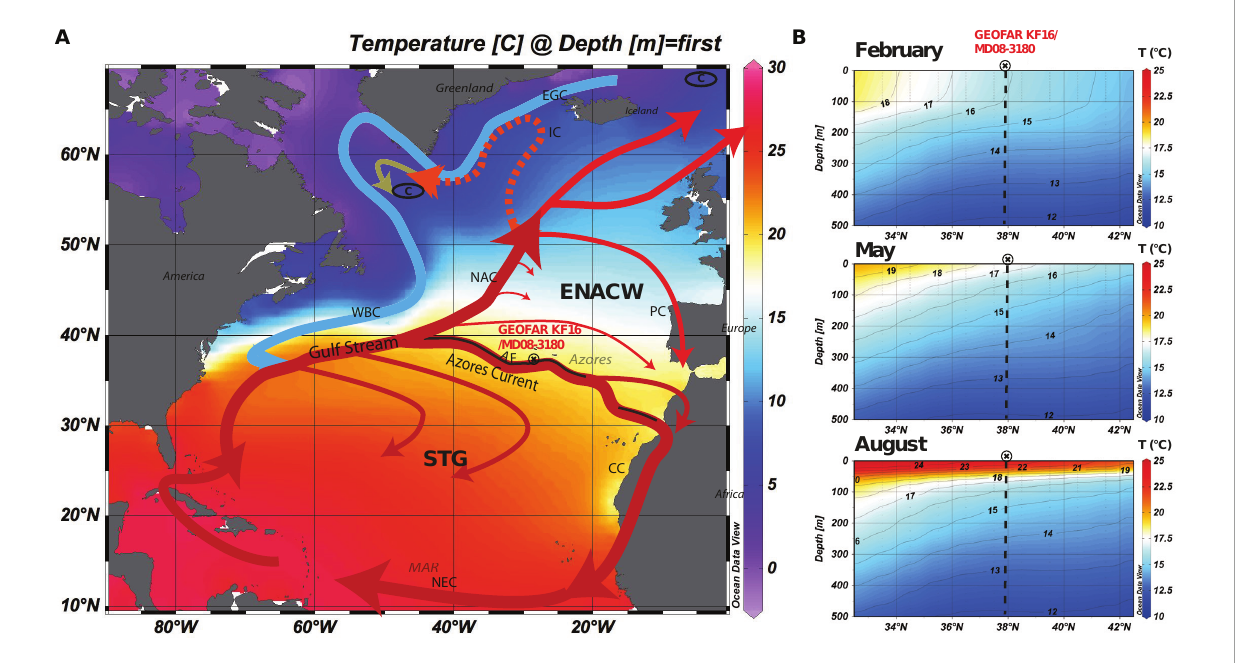
FIGURE1 (A) Main surface (solid lines) and subsurface (hatched line) currents in the North Atlantic. Warm currents are displayed in red, cold currents in blue. Color shading refers to annual mean SST (Locarnini et al., 2013). AF Azores Front, CC Canary Current, EGC East Greenland Current, ENACW Eastern North Atlantic Central Water, IC Irminger Current, NAC North Atlantic Current, NEC North Equatorial Current, PC Portugal Current, STG Subtropical Gyre, WBC Western Boundary Current, C Deepwater convection sites. (B) Cross sections on the modern temperature distribution across the AF along 28 ◦ W displaying spring to summer conditions (Locarnini et al., 2013) plotted with ODV (Schlitzer, 2012).